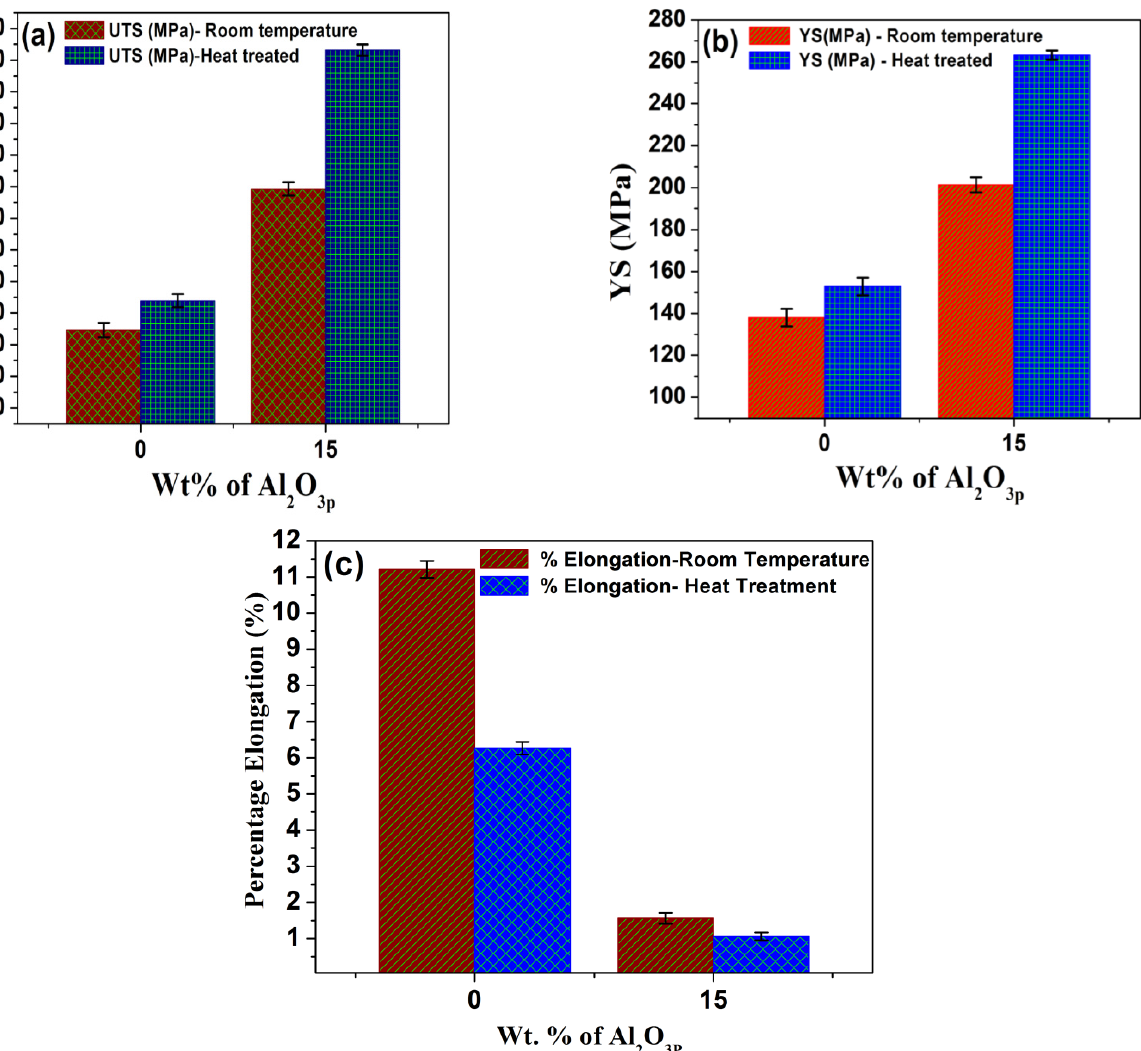
Figure 5. ( a , b ) Comparisons of UTS and YS values of Al2014 and Al2014-15 wt.% of Al 2 O 3 composites before and after heat treatment. ( c ) Comparisons of percentage elongation values of Al2014 and Al2014-15 wt.% Al 2 O 3 composites both at as-cast and heat-treated conditions. The T6 heat treatment has significant effects on the UTS and YS of Al2014 and Al2014-15 wt.% Al 2 O 3 composites. A solutionizing temperature of 525 ◦ C with a duration of about 1 h and an aging temperature of 175 ◦ C with a duration of 10 h significantly alters the UTS and YS of both Al2014 matrices alloys and Al2014-15 wt.% Al 2 O 3 MMCs. Figure 5a shows the enhancement in the UTS of the heat-treated base alloy (i.e., 167.90 ± 4.16 MPa) and Al2014-15 wt.% Al 2 O 3 MMCs (i.e., 326.39 ± 3.56 MPa) as contrasted to the base alloy (149.29 ± 4.53 MPa) and Al2014-15 wt.% Al 2 O 3 composite (238.54 ± 4.18 MPa) before heat treatment, respectively. An improvement in UTS of about 12.46% and 36.82% is noticed in the heat-treated base alloy and Al2014-15 wt.% Al 2 O 3 composite, respectively, as contrasted to the base alloy, the Al2014-15 wt.% Al 2 O 3 MMCs without heat treatment. Figure 5b shows the enhancement in YS of the heat-treated base alloy (152.89 ± 4.28 MPa) and Al2014-15 wt.% Al 2 O 3 MMCs (263.23 ± 2.23 MPa) as contrasted to the base alloy (138.01 ± 4.19 MPa) and Al2014-15 wt.% Al 2 O 3 composite (201.29 ± 3.56 MPa) before heat treatment, respectively. An improvement in the YS of about 10.78% and 30.77% in the heat-treated base alloy and Al2014-15 wt.% Al 2 O 3 composite is noticed, respectively, as contrasted to the base alloy and Al2014-15 wt.% Al 2 O 3 composite without heat treatment. This enhancement in UTS and YS of the heat-treated Al2014 alloy and